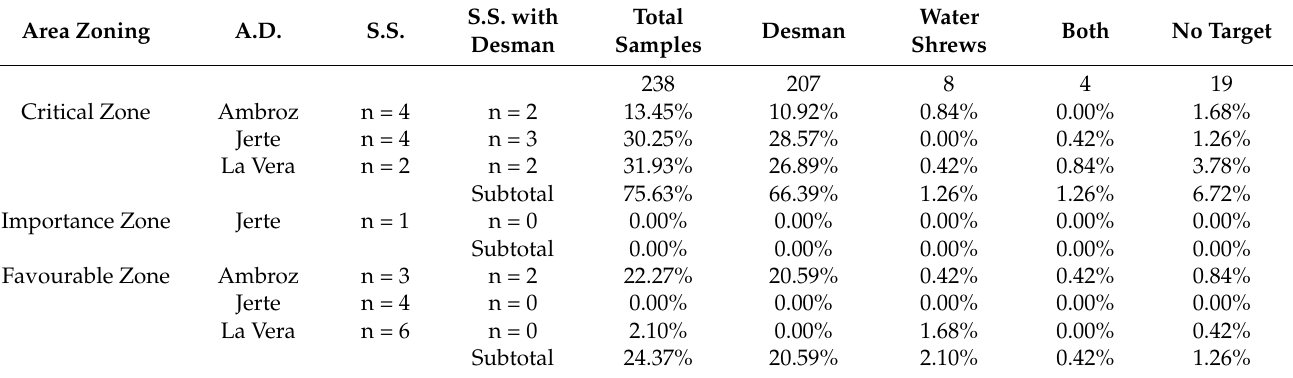
Table 1. Geographical distribution of samples from 2018 to 2021 by administrative district (A.D.) and sampling sections (S.S.). Percentages are calculated based on all samples (n = 238).